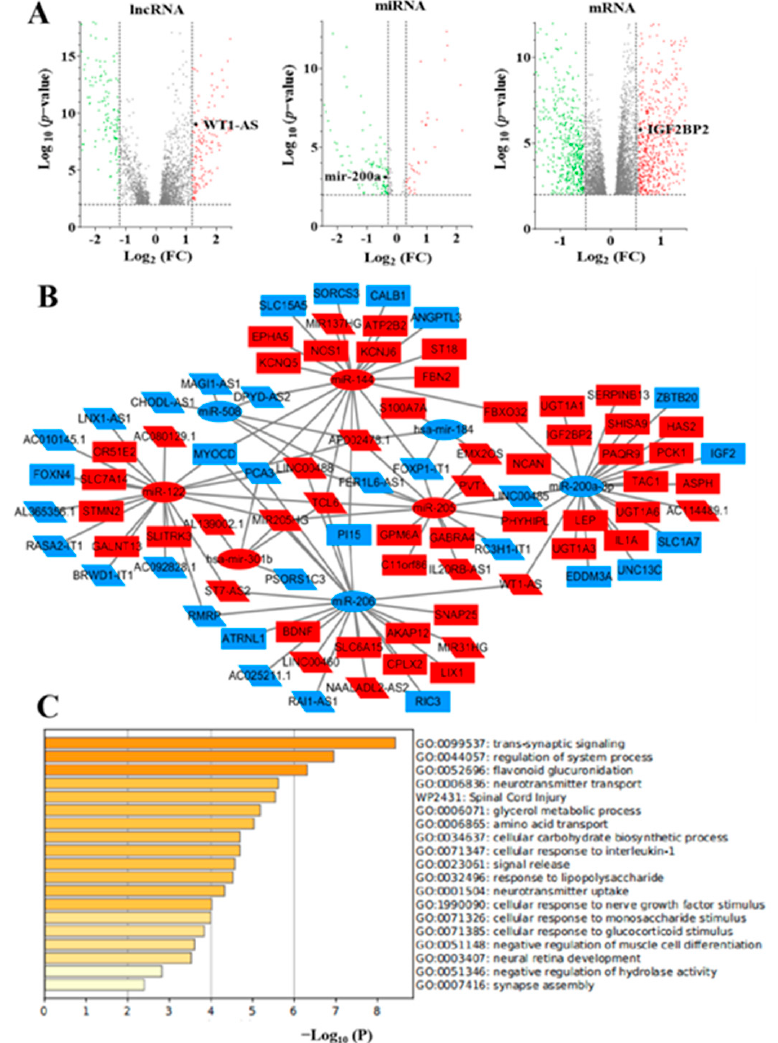
Figure 2. The c-Myc-related ceRNA network in LUAD. ( A ) The vocano plot of lncRNAs, miRNAs and mRNAs. Red stands for upregulation and green stands for downregulation. ( B ) The c-Myc- related ceRNA regulatory network in LUAD. The oval represents miRNAs, the diamond represents lncRNAs, and the rectangle represents mRNAs. Red stands for upregulation and blue stands for downregulation. ( C ) Functional enrichment analysis of mRNAs in the